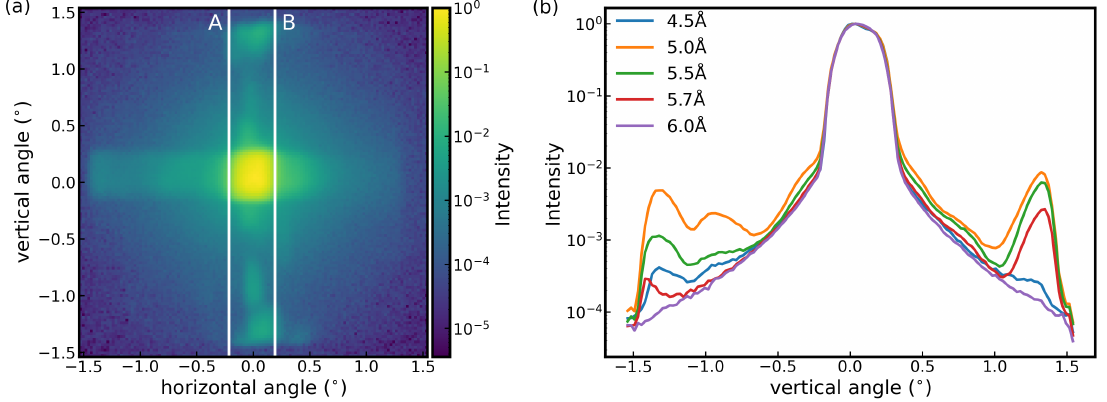
Figure 6. Spurious scattering as caused by the transmission bender device. ( a ) Detector image with spurious scattering in the vertical plane located within the boundaries, marked A, B. ( b ) Vertical cuts across the detector image in ( a ) integrated between A and B. The direct beam corresponds to the intense peak at the detector center. From 4.5Å to 5.9Å, additional peaks occur at an angle of close to the top and bottom edges of the detector.